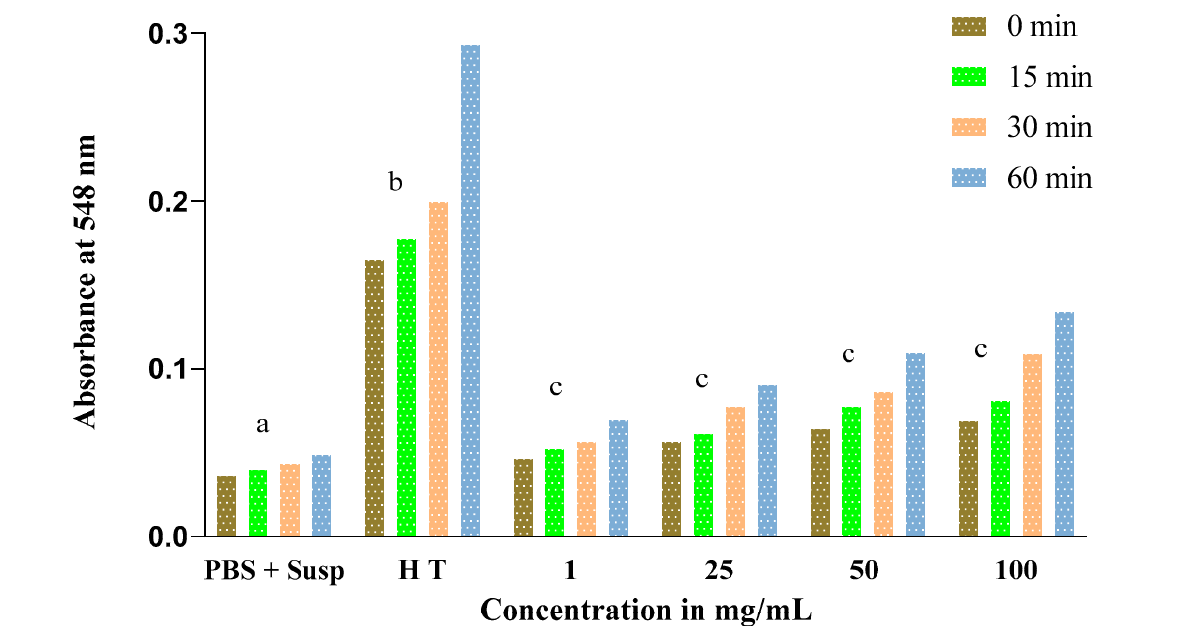
Figure 8. Evolution of absorbance in tubes containing erythrocyte suspension as a function of different concentrations of the total extract of Lepidium sativum. Letters (c) indicate a non-significant difference. Different letters (a,b) indicate a significant difference.